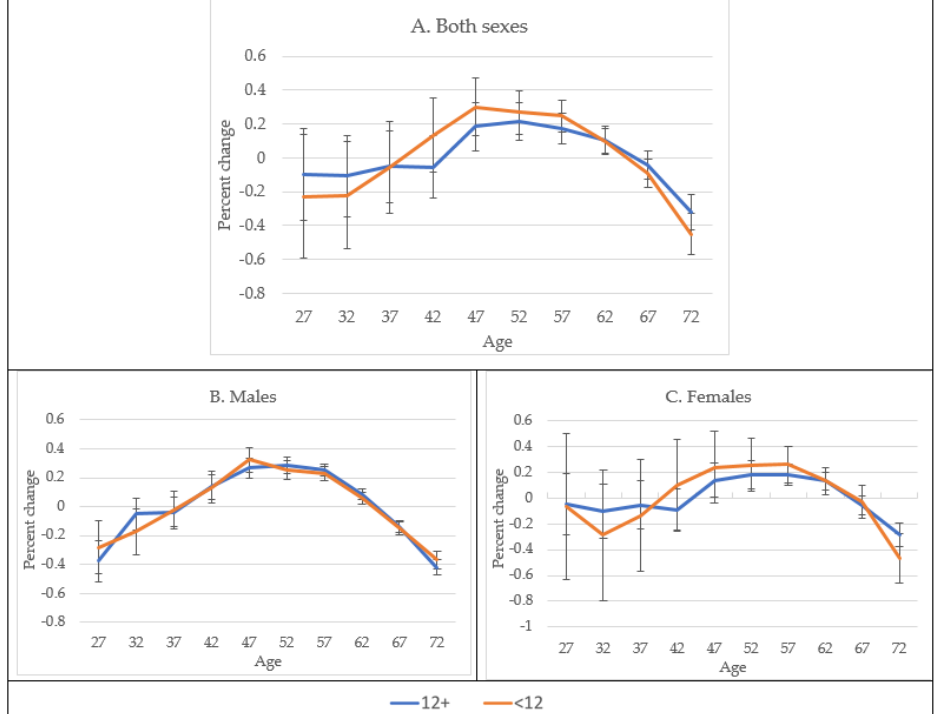
Figure 5. Age deviation of diabetes mortality rates (in percent) among Hispanics by sex and education level, United States, 1989 – 2018. Percent change was compared to mortality at age 50 years.